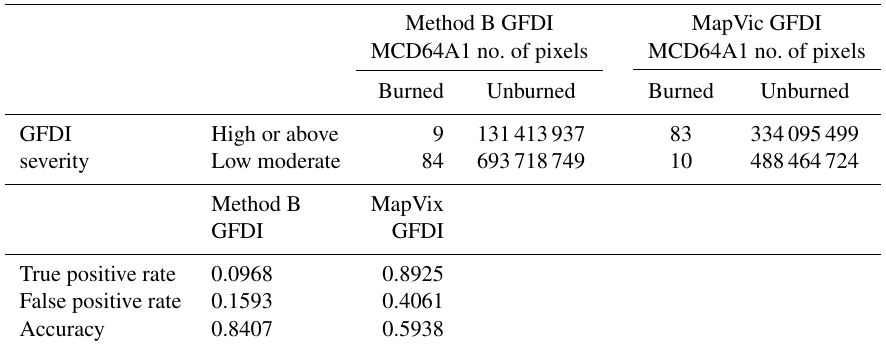
Table 4. Recalculated Grassland Fire Danger Index (GFDI) severity and burned–unburned area contingency table for degree of curing (DOC) computed with Method B (Newnham et al., 2010) and MapVic (Martin et al., 2015) model. Reference GFDI is computed from constant DOC at 100%, while recalculated GFDI is computed from satellite-based